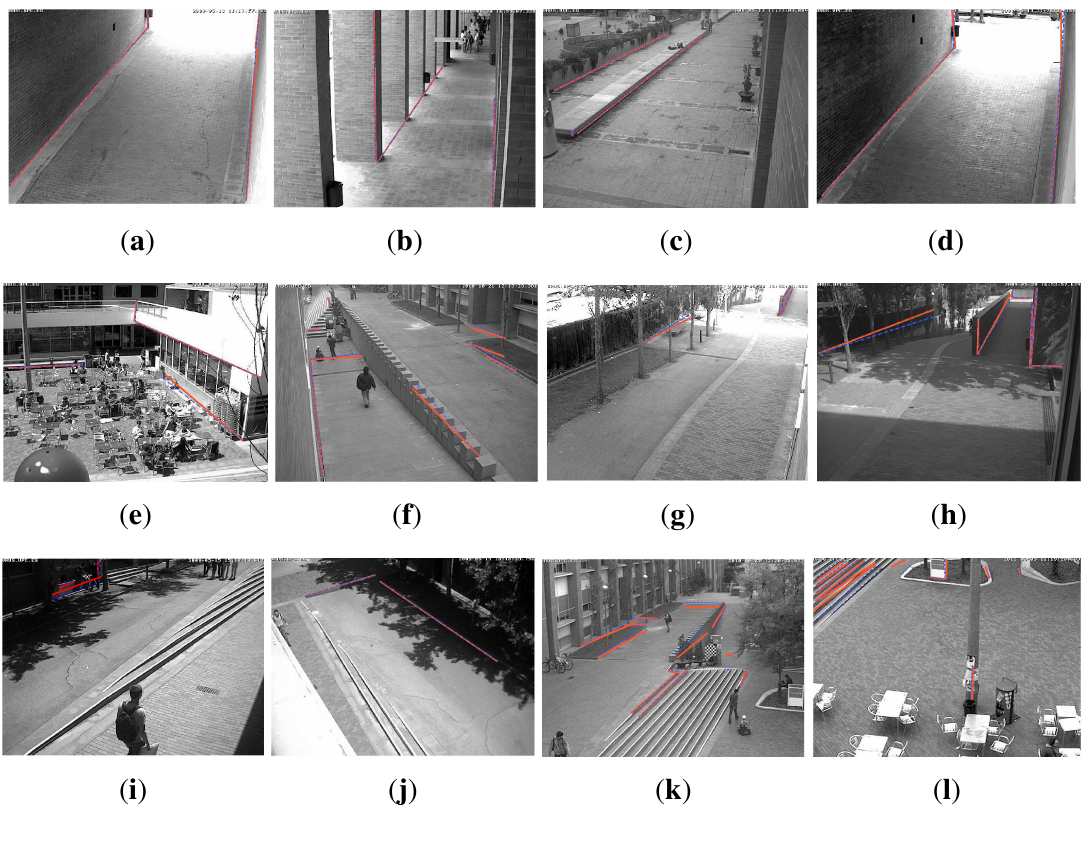
Figure 9. Results of the final calibration of the camera network for the BRL scenario. Optimization approximates the projected laser lines ( blue ) to the image lines ( red ). ( a )